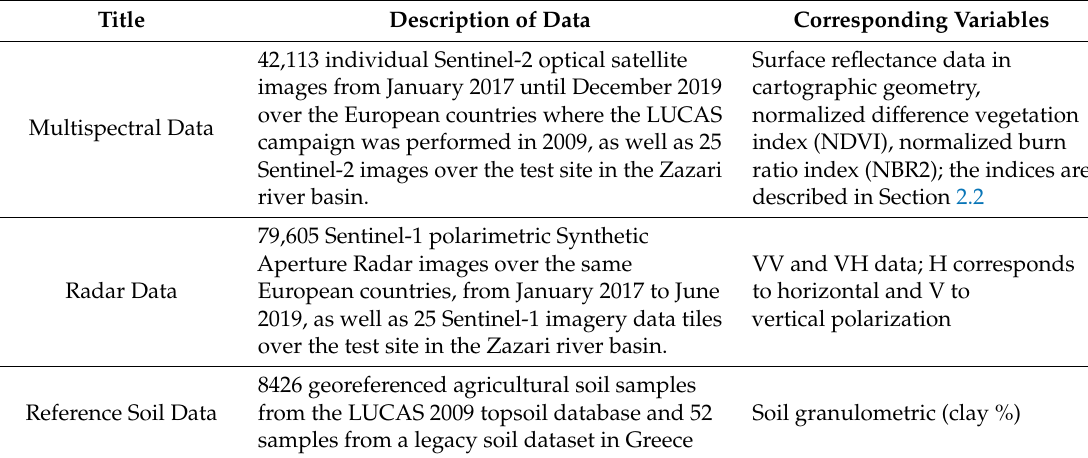
Table 1. Description of the Earth observation (EO) datasets included in the current study along with the corresponding variables as derived from each source and the soil reference